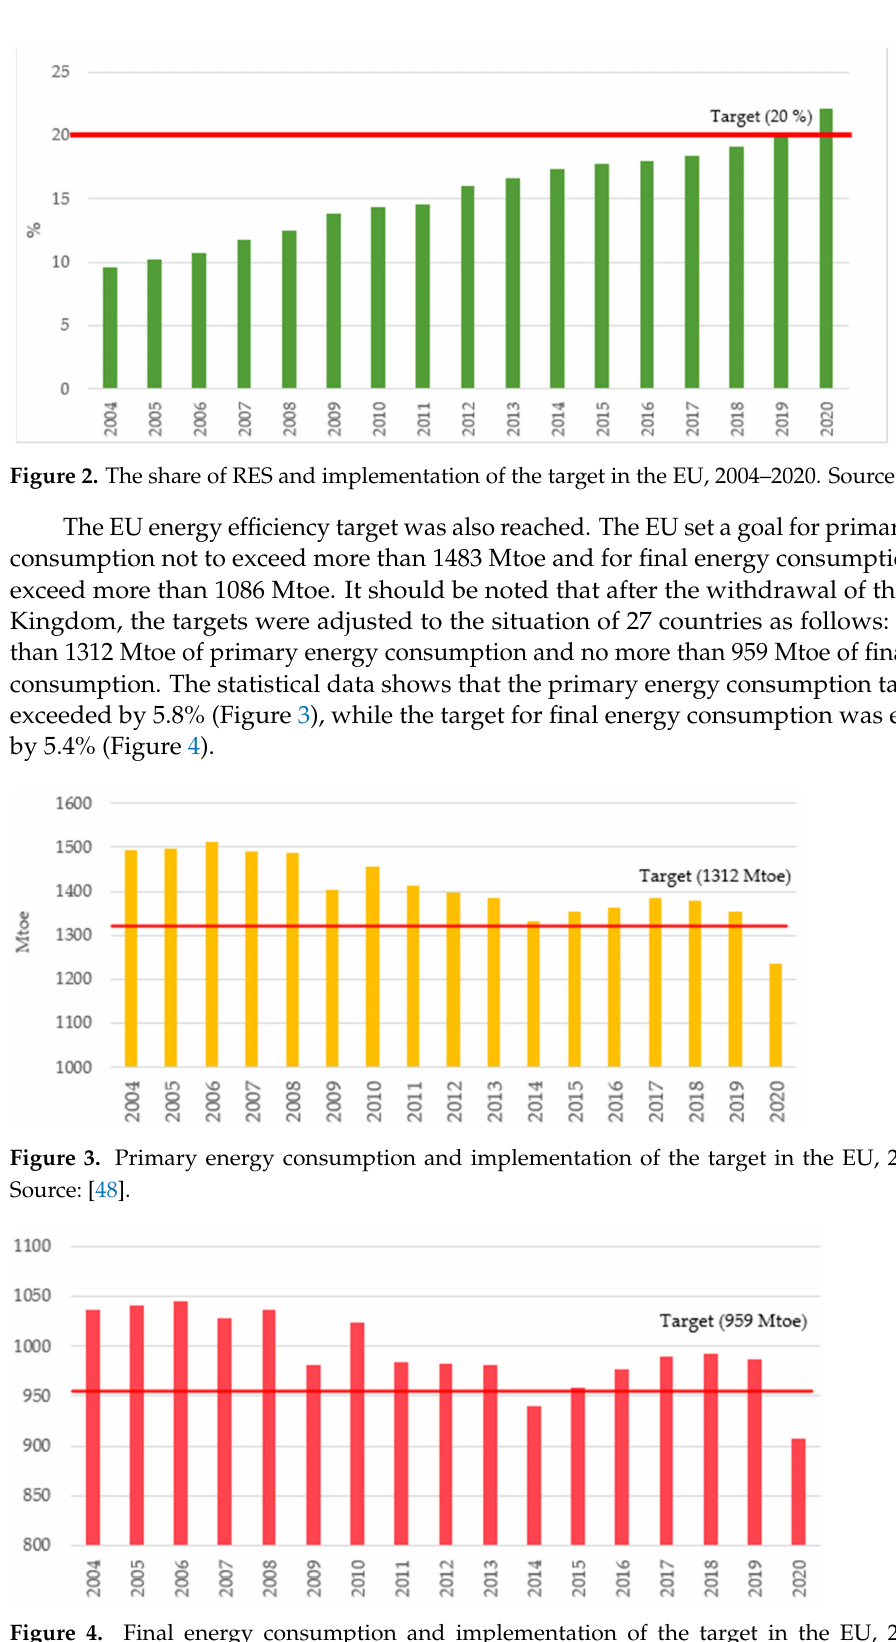
Figure 4. Final energy consumption and implementation of the target in the EU, 2004–2020. Source: